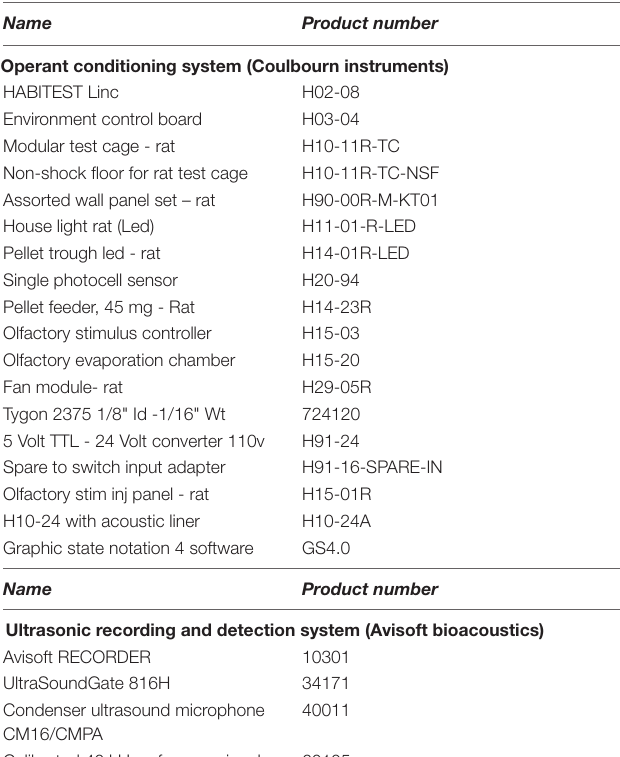
TABLE 1 | Detailed list of equipment and